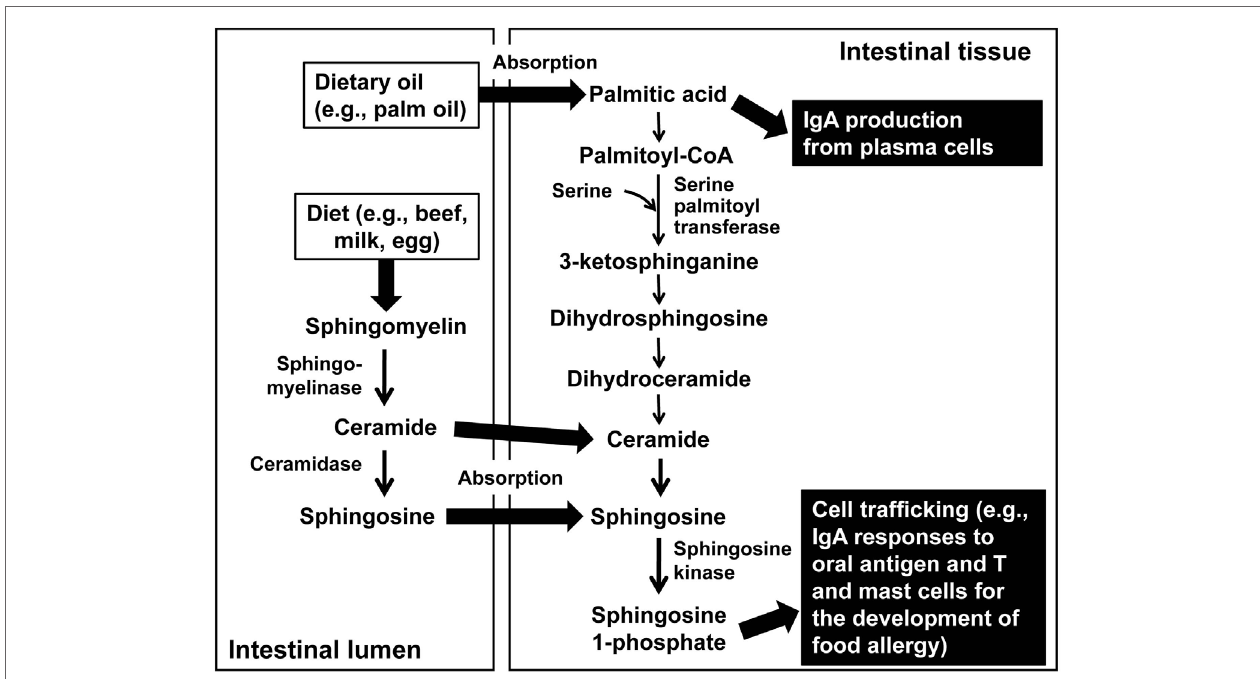
FiGURe 2 | Two pathways for the generation of sphingolipids in the control of immune responses in the intestine. Palmitic acid is absorbed from dietary oil (e.g., palm oil) into the intestinal tissue where it directly stimulates IgA-producing plasma cells to enhance IgA production. Simultaneously, palmitic acid is metabolized into the sphingolipids, such as ceramide, sphingosine, and sphingosine 1-phosphate. In the other pathway, sphingomyelin abundantly present in the diets, such as beef, milk, and egg is metabolized into ceramide and then to sphingosine in the intestinal lumen. Both ceramide and sphingosine are absorbed into the intestinal tissue where they are further metabolized into the sphingosine 1-phosphate. Sphingosine 1-phosphate regulates cell trafficking and thus controls the IgA antibody responses to oral antigen. It also participates in the development of food allergy by controlling T and mast cell trafficking and/or